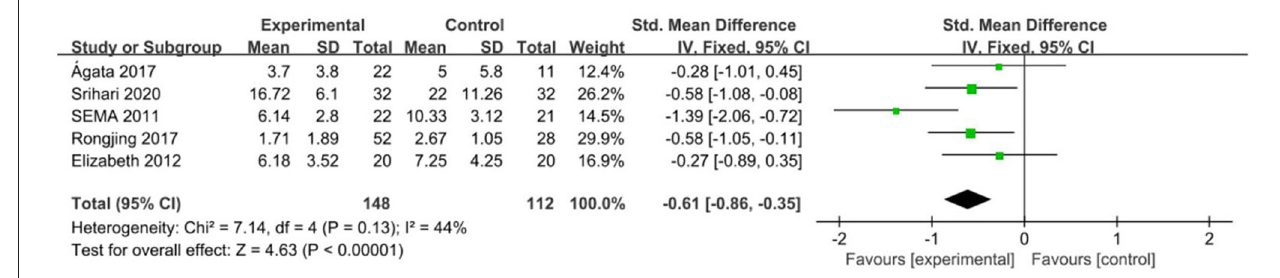
FIGURE 4 | Meta-analysis: anxiety in coronary heart disease patients.